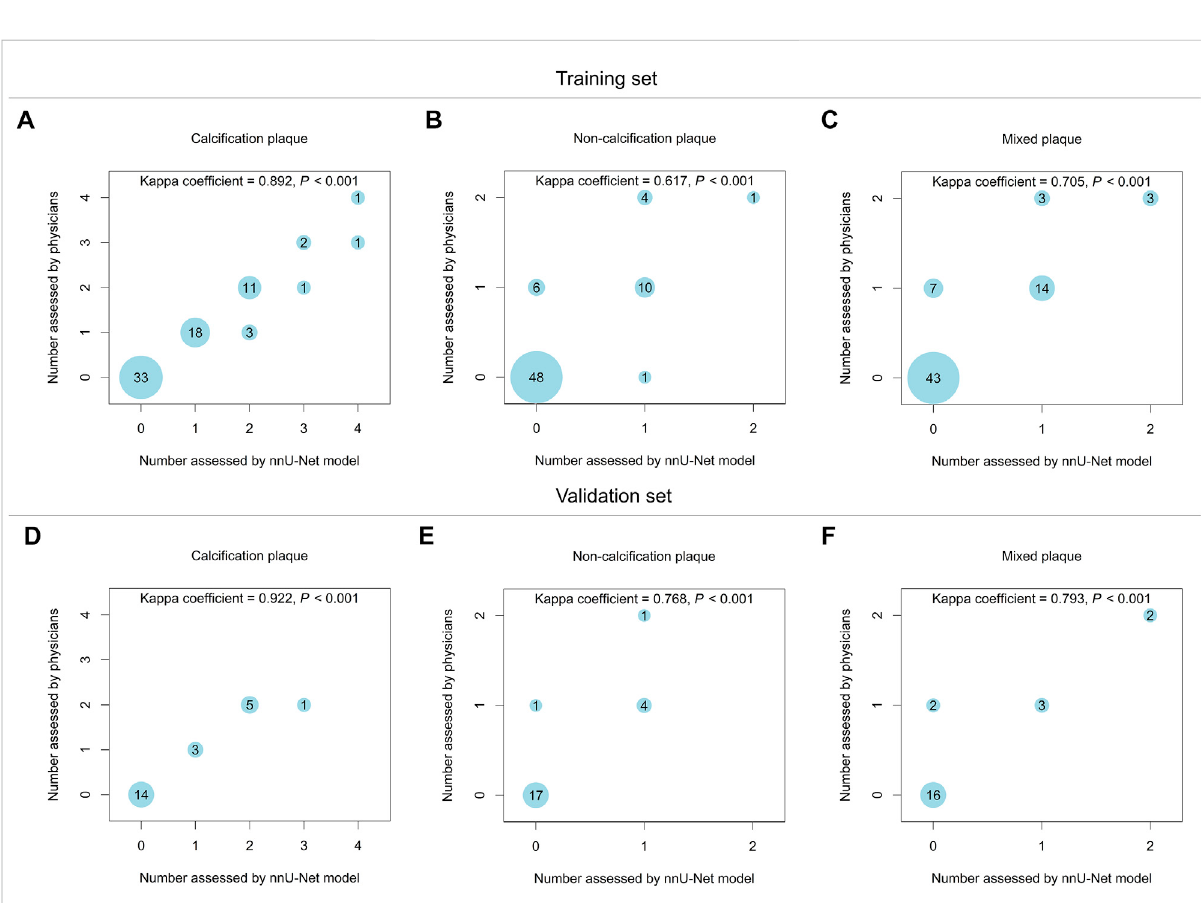
FIGURE 2 The nnU-Net model showed good consistency of atherosclerotic plaque number evaluation with physicians in the training set and validation set. The consistency between the nnU-Net model and physicians in evaluating the number of calci fi cation plaque (A) , non-calci fi cation plaque (B) , and mixed plaque (C) in the training set. The consistency between the nnU-Net model and physicians in evaluating the number of calci fi cation plaque (D) , non-calci fi cation plaque (E) , and mixed plaque (F) in the validation set.